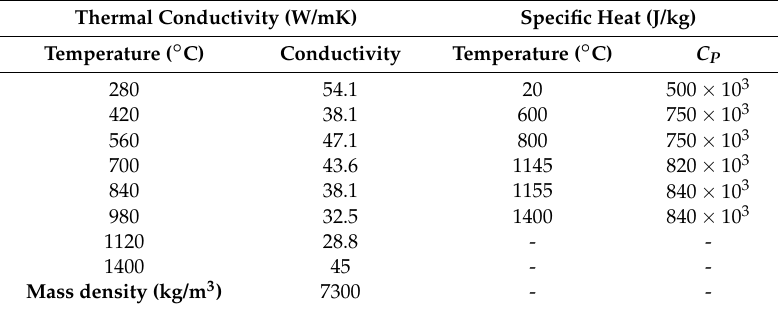
Table A1. Material parameters of